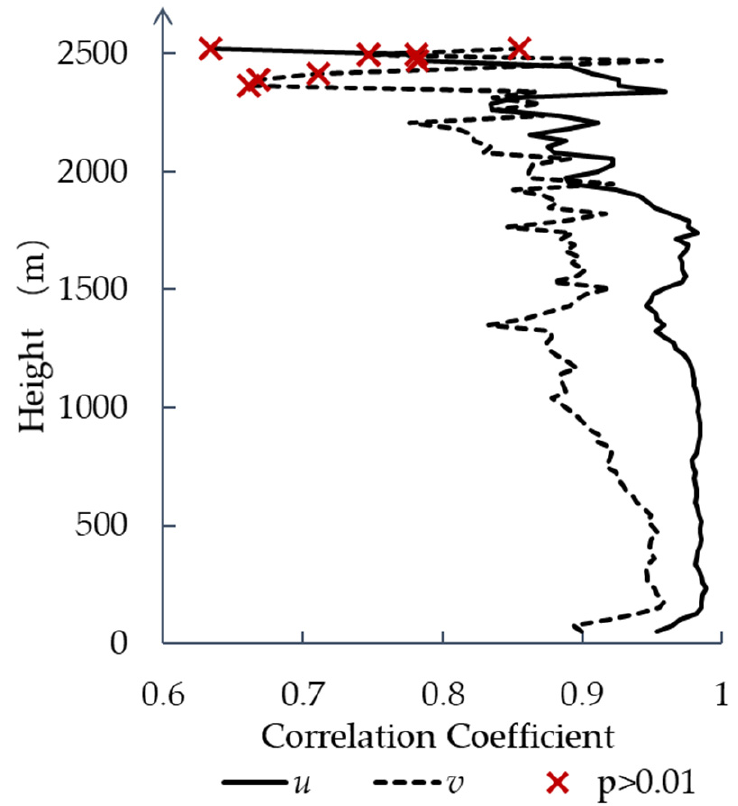
Figure 3. Correlation curves of the CDWL observed u and v wind fields with the GTS sounding observations ( p > 0.01 does not pass significance test).